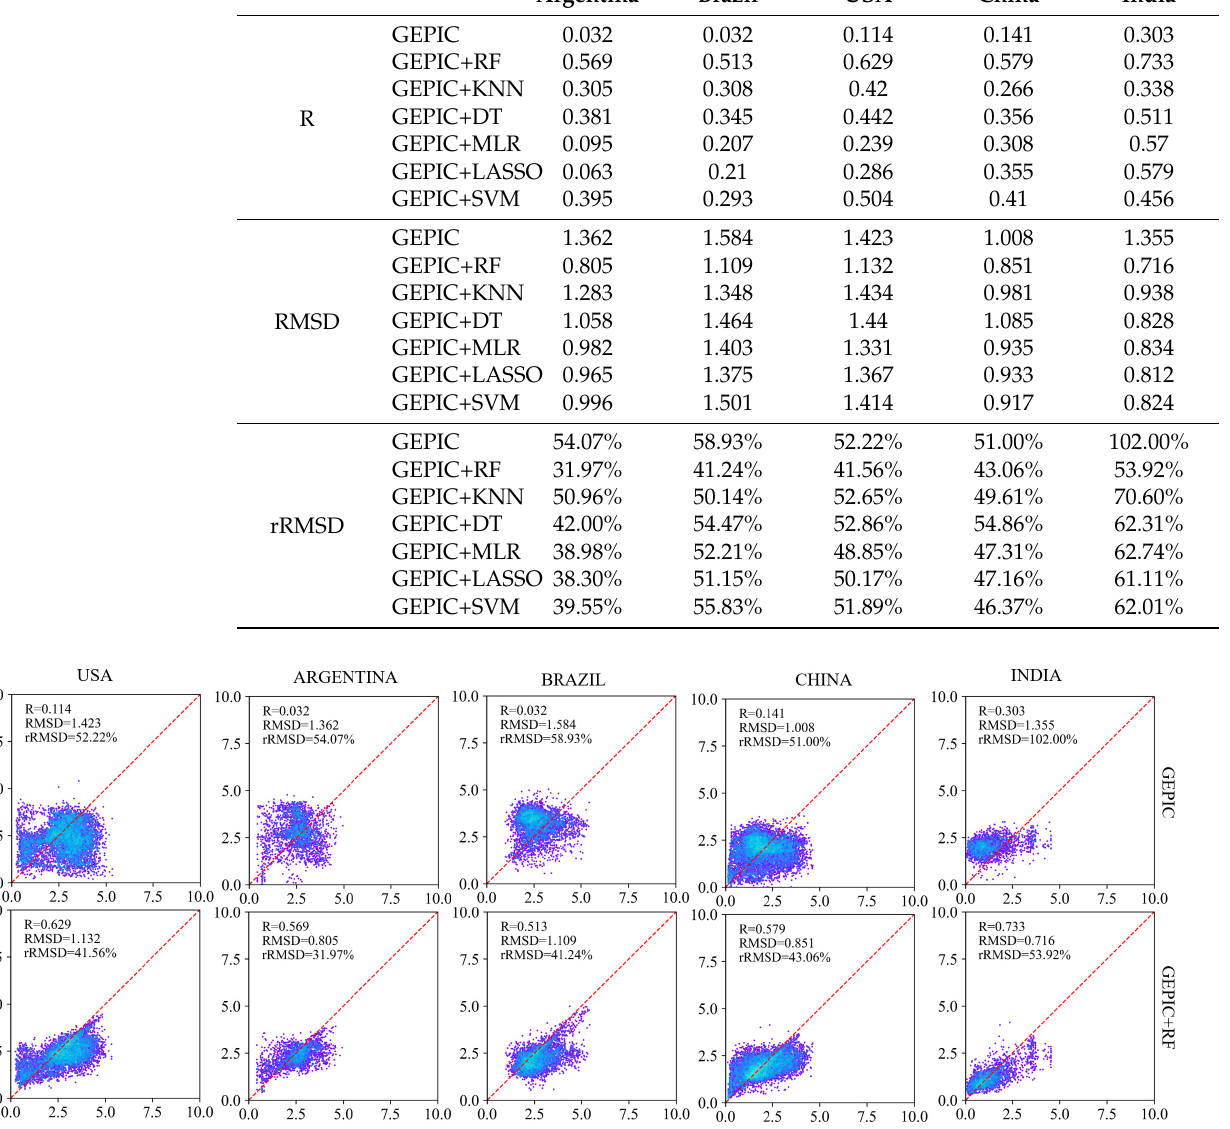
Figure 4. Spatial distribution comparisons of RMSD (t/ha) between the GEPIC and GEPIC+RF model. 3.2. Importance Analysis of Extreme Climate Indicators for Soybean Yield We used the RF model to estimate the importance (number of y axis) of extreme cli- mate indicators for the globe and the five main soybean producing countries (Figure 5). The higher the importance value is, the more decisive the extreme climate indicator was. At the global scale, the most affecting extreme climate indicator was the Tmin, followed